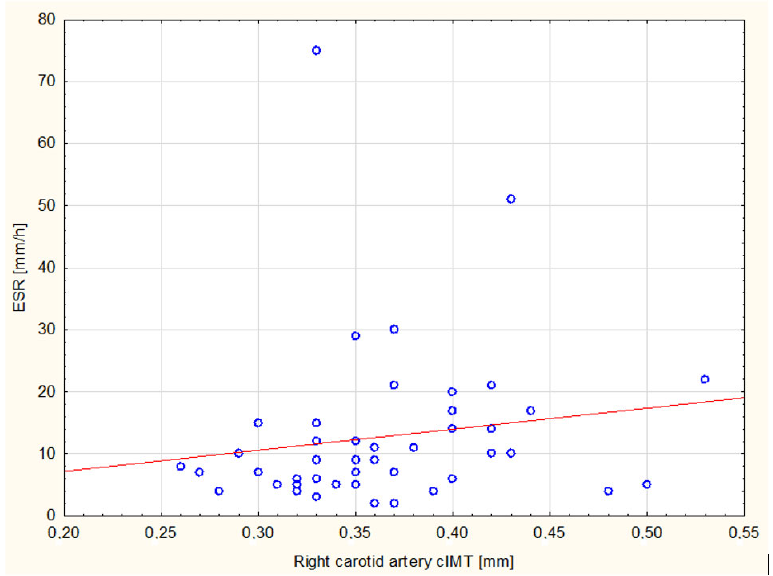
Figure 2. Correlation between erythrocytes sedimentation rate (ESR) values and right carotid artery (RCA) carotid intima ‐ media thickness (cIMT).